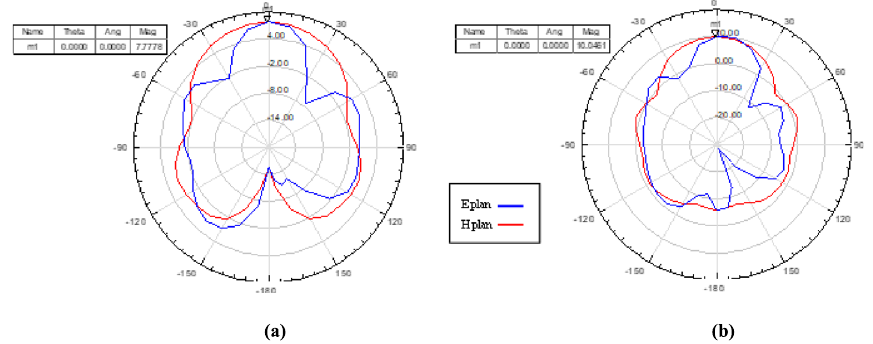
Fig. 18 The radiation pattern of microstrip patch antenna with dielectric superstrate. a Antenna with one layer. b Antenna with two